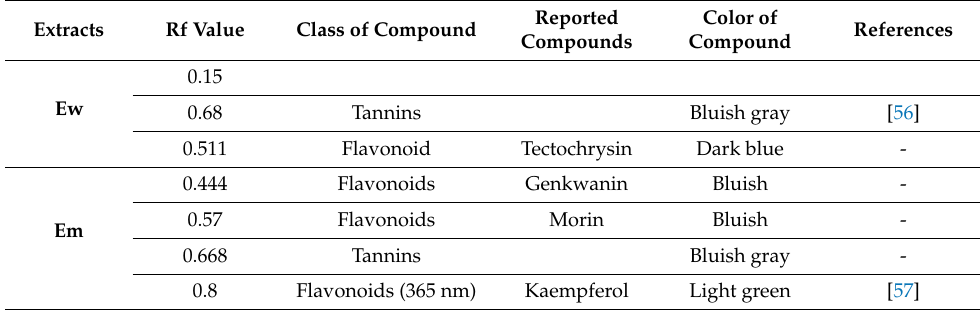
Figure 1. Thin layer chromatography of methanol and methanol:water extract of Aerva javanica with solvent media methanol:chloroform (9:1, 4:1). Table 2. Phytochemicals identified through TLC (thin layer chromatography) in methanol and the methanol:water extracts of Aerva javanica